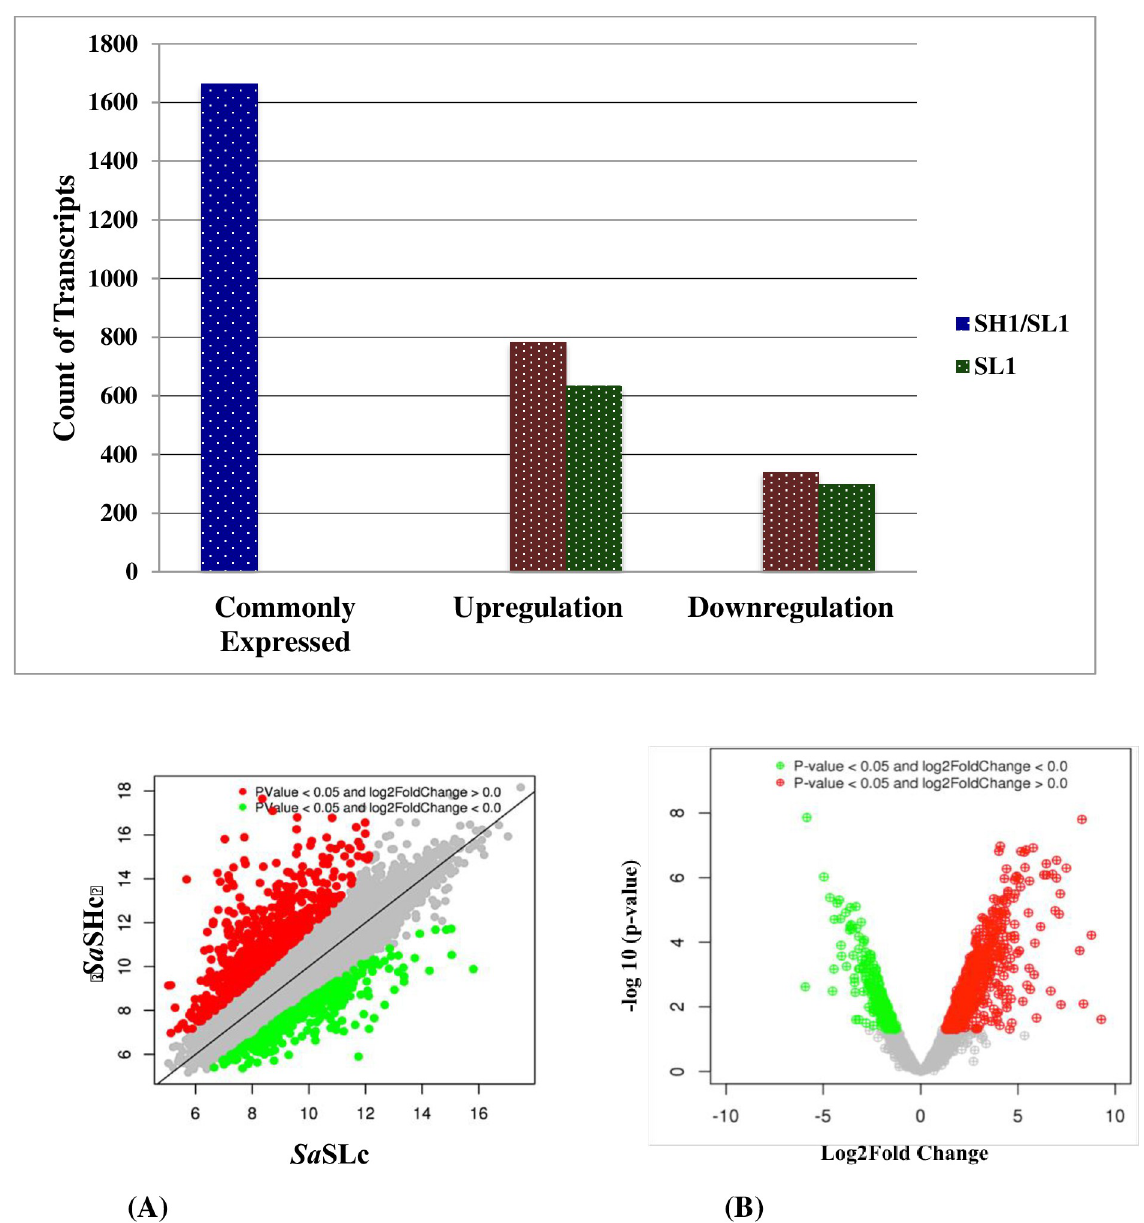
Fig 6. Top blast hit species distribution of coding sequence (CDS); Majority of the hits were found to be against Vitis vinifera